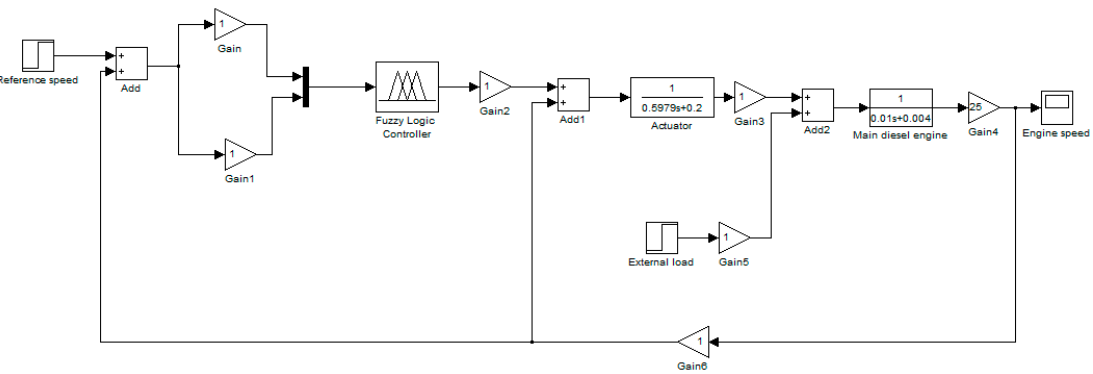
Figure 12. Simulation model of marine diesel engine speed Controller.